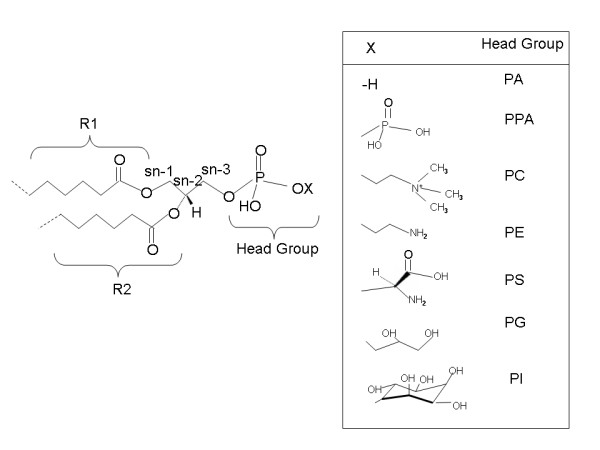
Structures of major glycerophospholipids. R1, R2 and X are SMILES seed variables at sn-1, sn-2 and sn-3 positions respectively. Head groups legend: PA = Phosphate, PPA = Pyrophosphate, PE = Phosphoethanolamine, PC = Phosphocholine, PS = Phosphoserine, PG = Phosphoglycerol, and PI = Phosphoinositol.